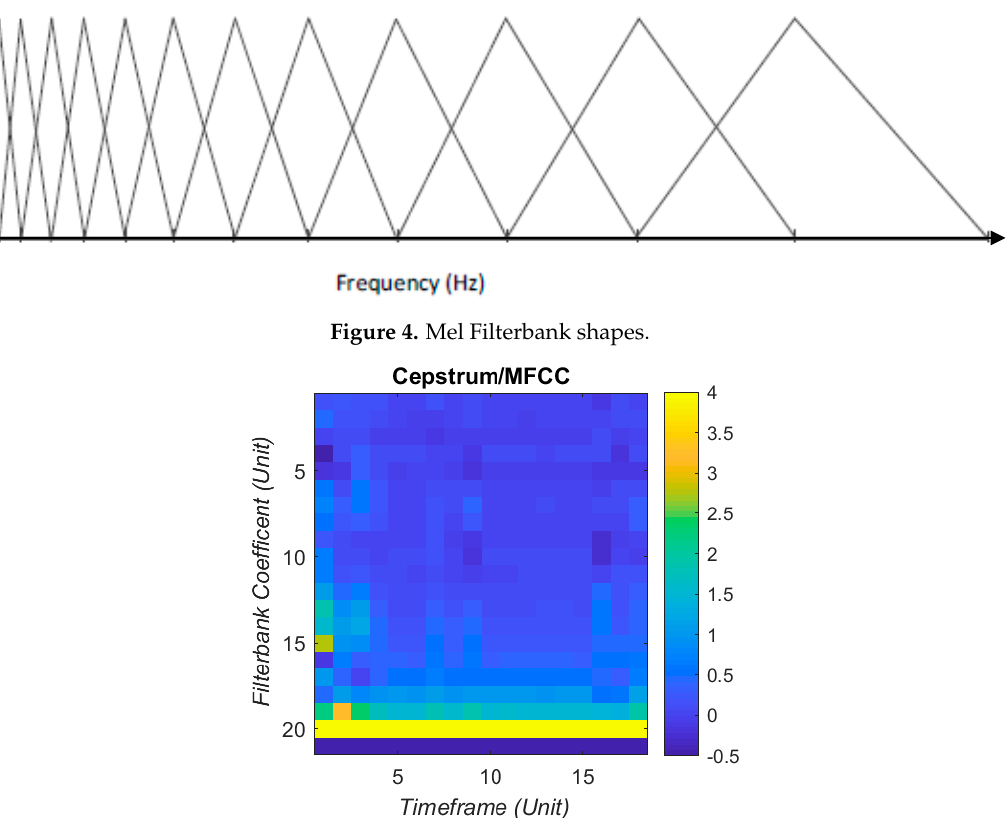
Figure 5. Cepstrum coefficient sum of IR. (Colour bar is clipped to increase resolution).